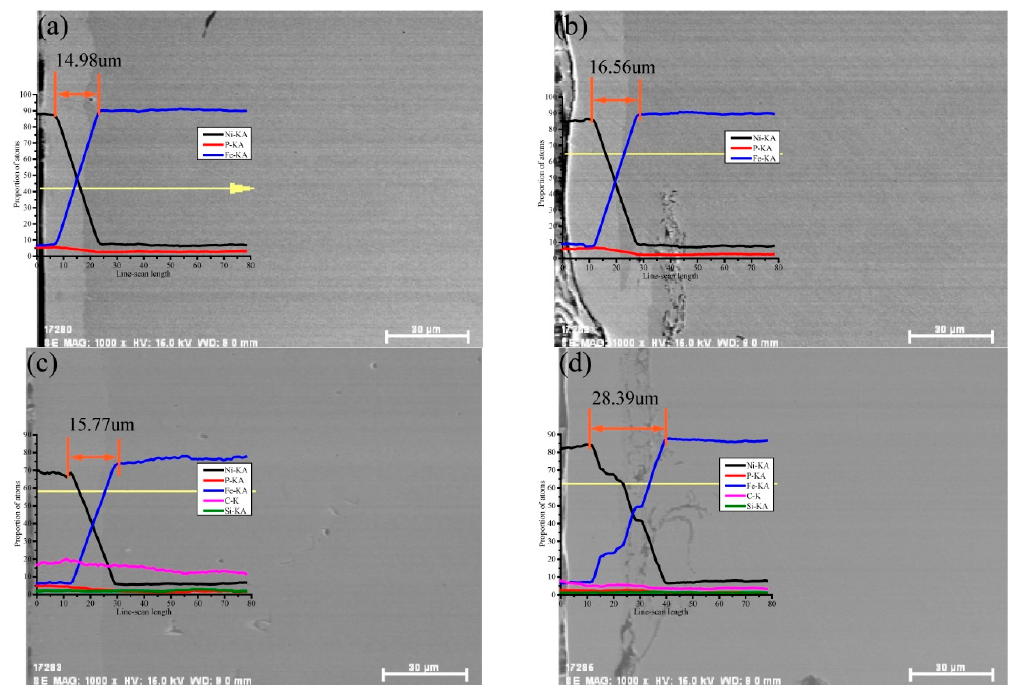
Figure 6. Section element scanning results of coatings on 45 steel substrates, prepared by scanning electrodeposition with different pretreatment processes: ( a ) Ni–P(P), ( b ) Ni–P(S), ( c ) Ni–P–SiC(P), and ( d ) Ni–P–SiC(S).